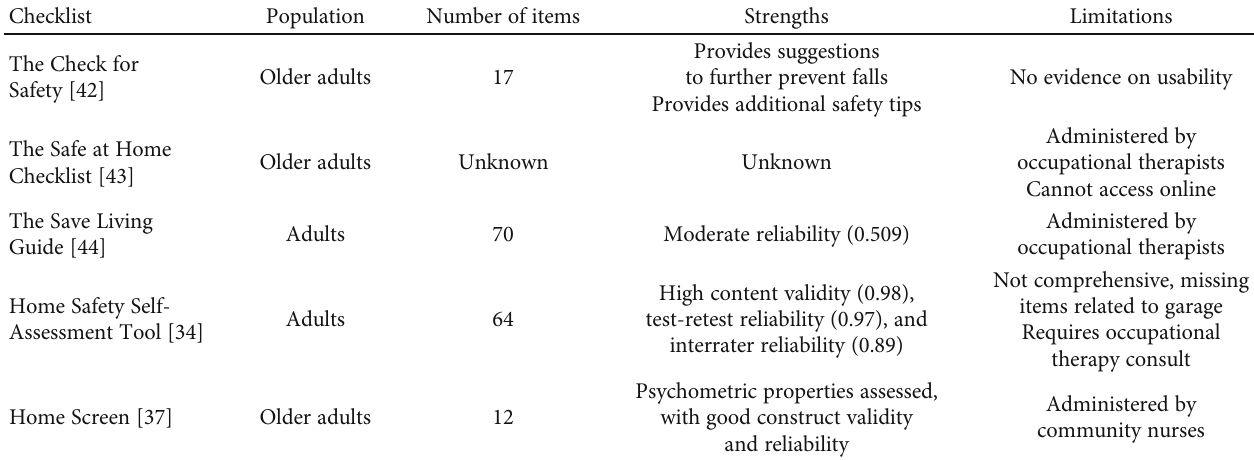
Table 1: Comparison of currently published home fall hazard